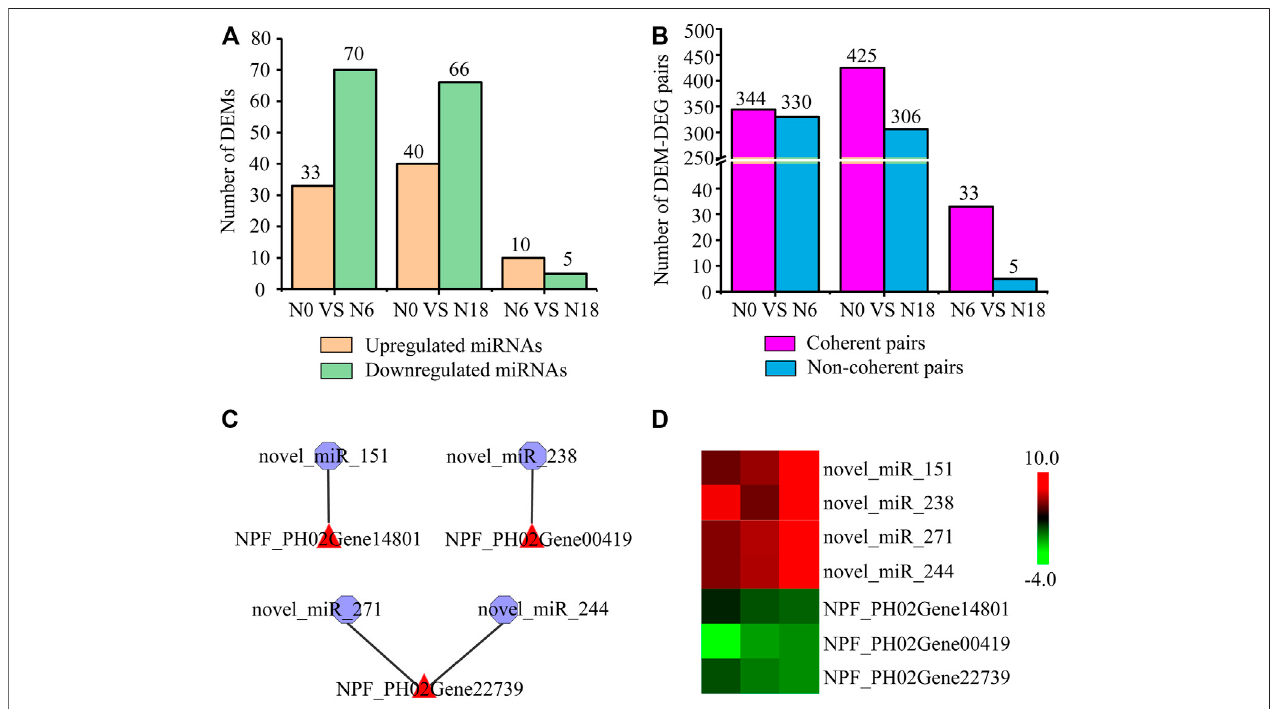
FIGURE 5 | Analysis of DEMs and their targeted genes: (A) statistics of DEMs; (B) statistics of DEM-DEG pairs with similar or opposite expression patterns; (C) DEM-DEG pairs involved in nitrogen metabolism; (D) expression analysis of DEM-DEG pairs using transcriptome data. Heat map colors varied from green to red, representing low to high gene